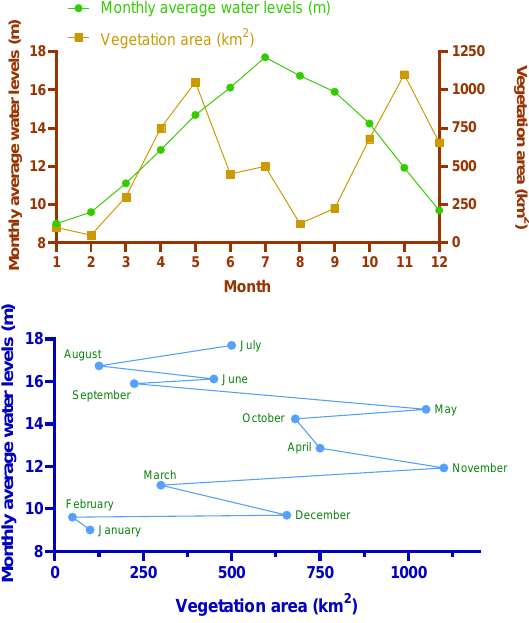
Figure 2. Relationships among months, vegetation area, and monthly water levels. The vegetation area [33] is assumed to be proportional to the vegetation transpiration rate [34]. The monthly water levels are calculated by 61 years of data from 1953 to